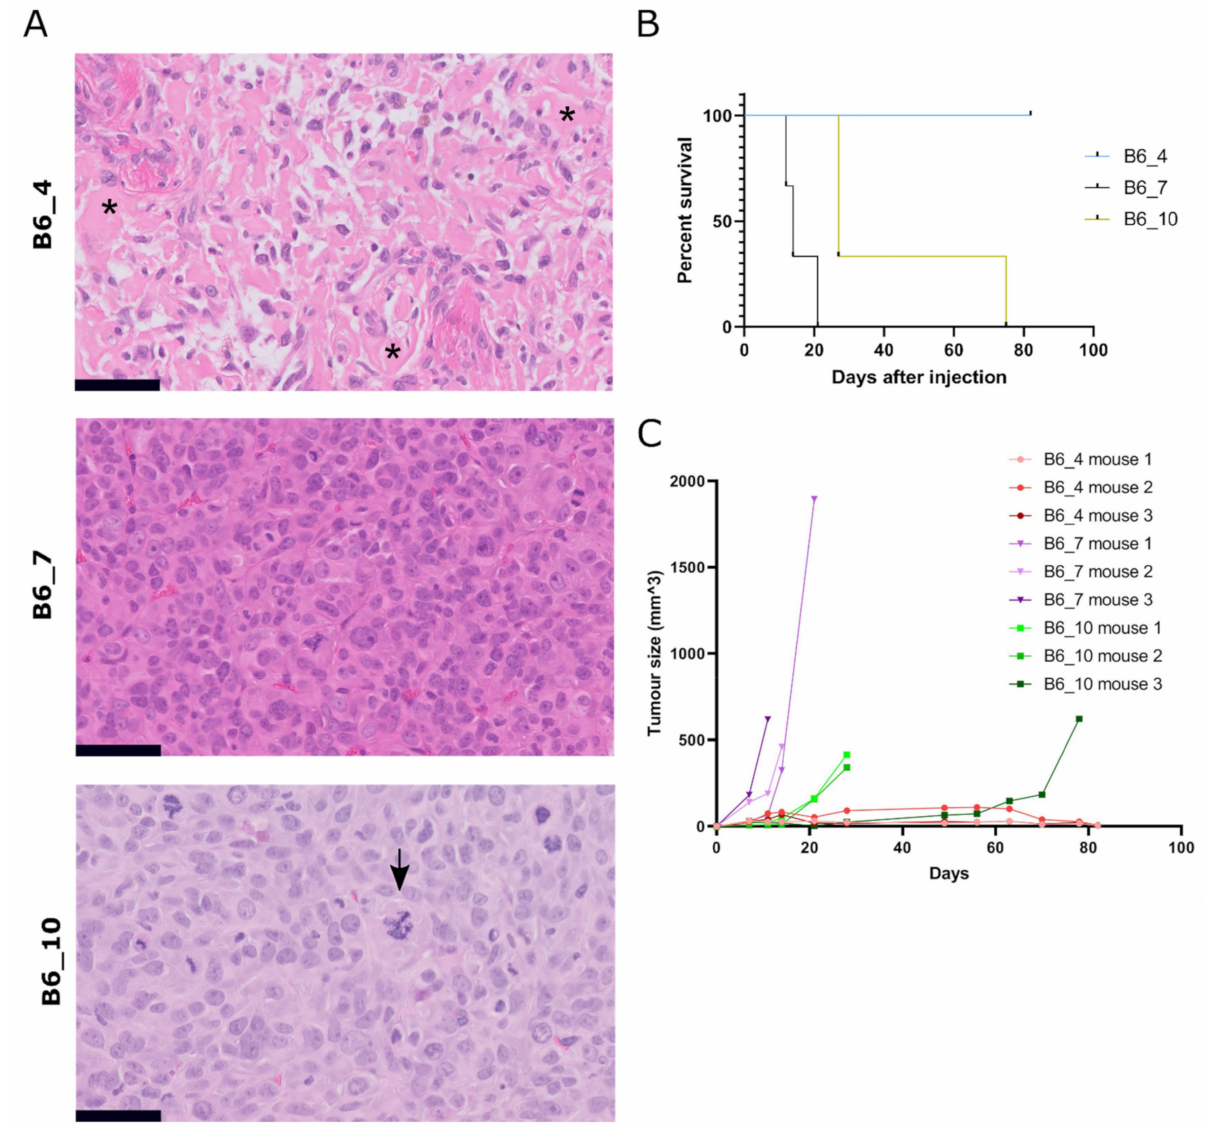
Figure 4. Subcutaneous injection of transformed murine MSCs result in tumor formation with variable histology. ( A ) H&E staining of tumors formed after subcutaneous injection of transformed murine MSCs (B6_4, B6_7, B6_10). Tumor B6_4 displayed a moderately cellular and pleomorphic tumor with deposition of amorphous eosinophilic extracellular matrix, suggestive of osteoid (indicated with asterisks). In contrast, tumors B6_7 and B6_10 were more cellular, pleomorphic, with a high number of mitoses, and morphologically lack any differentiation. Atypical mitosis were present, indicated with an arrow in B6_10. Tumor volumes for B6_4, B6_7 and B6_10 were 0.005 cm 3 ( n = 2), 0.4–1.1 cm 3 ( n = 3) and 0.3–0.6 cm 3 ( n = 3), respectively. Scalebar represents 50 µ m. ( B ) Number of days after subcutaneous injection when mice were sacrificed due to an increase in tumor volume. ( C ) Tumor size measured by calliper of each mouse after subcutaneous injection of transformed murine MSCs (t =